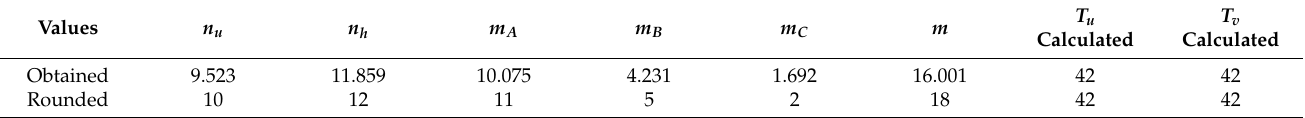
Table 2. Results obtained using formulas for the restricted case.